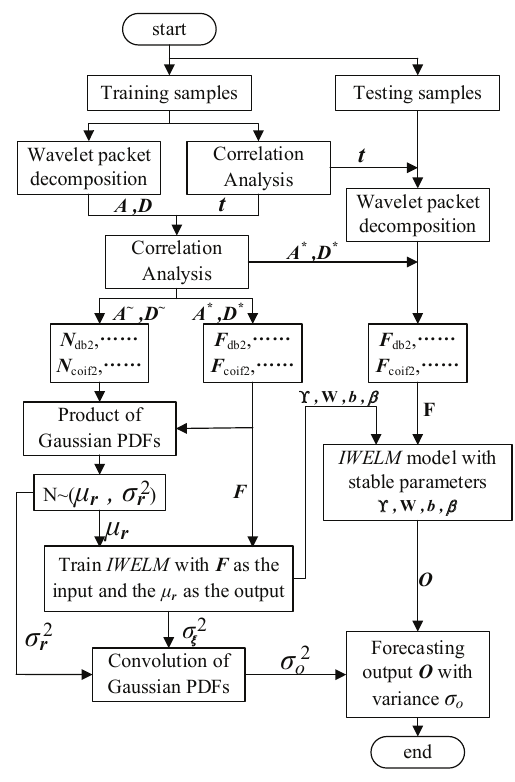
Figure 6. Flowchart of the proposed integration scheme.